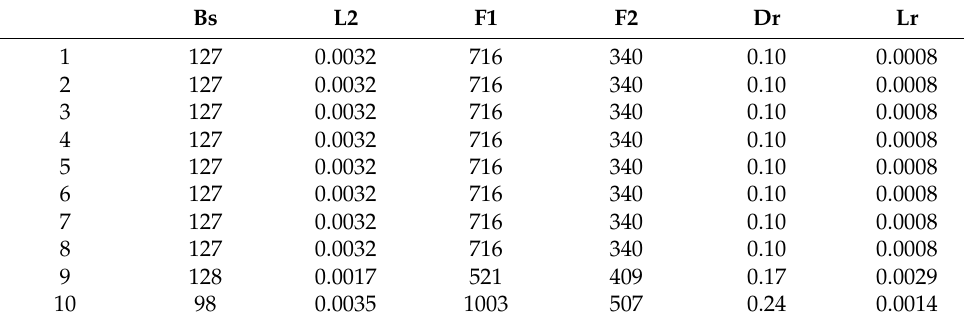
Table 11. Positions of individuals of PSO in the experiment on